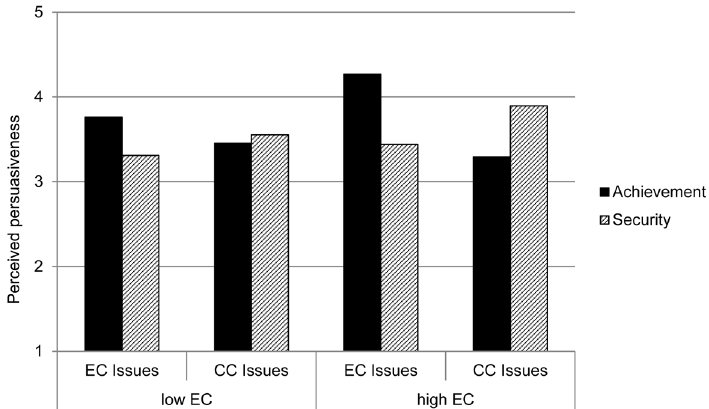
Figure 3. Perceived persuasiveness as a function of type of issue, type of benefit and economic conservatism (Study 2).